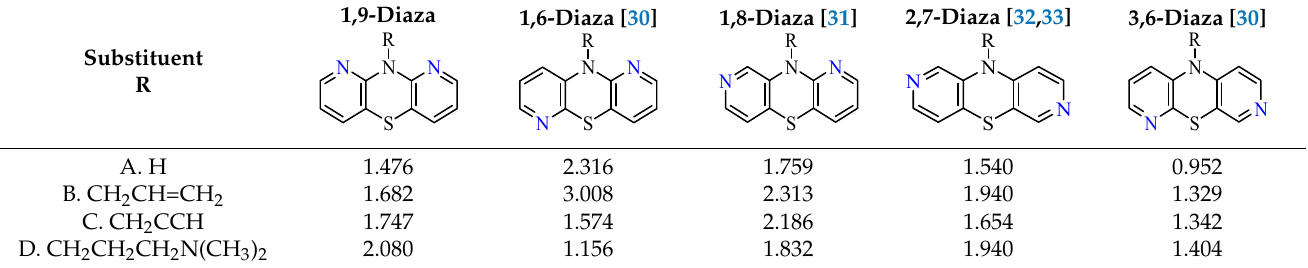
Table 9. Comparison of the lipophilicity parameter logP TLC of selected isomeric diazaphenothiazines. Table 9 . Comparison of the lipophilicity parameter logP